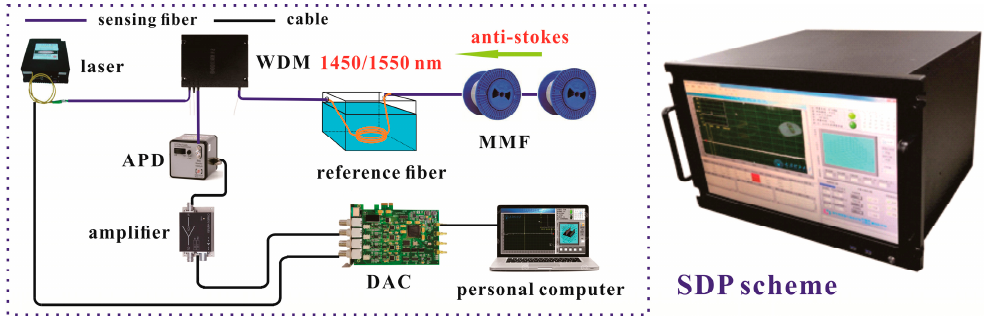
Figure 8. The experimental setup for SDP scheme. APD: Avalanche Photodiode; Amp: Amplifier; WDM: Wavelength Division Multiplexing; MMF: Multimode Fiber; DAC: High-speed Data.